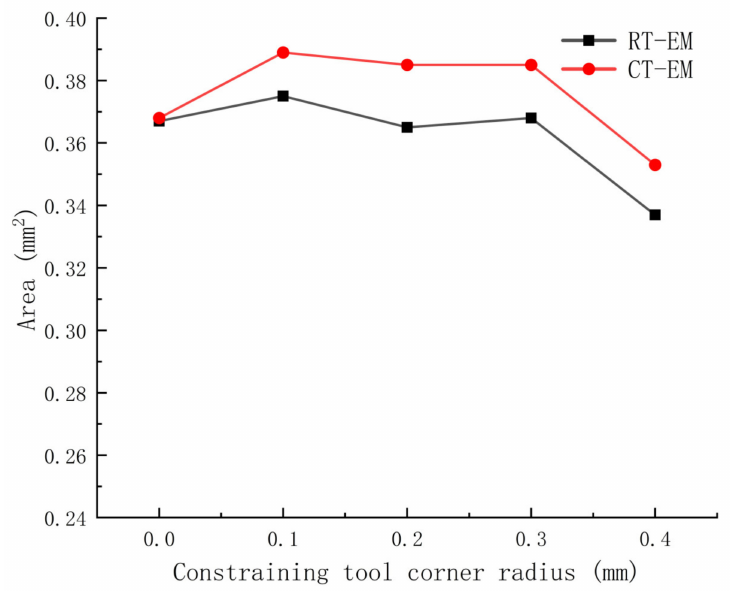
Figure 27. Cross-sectional area of the micro-groove